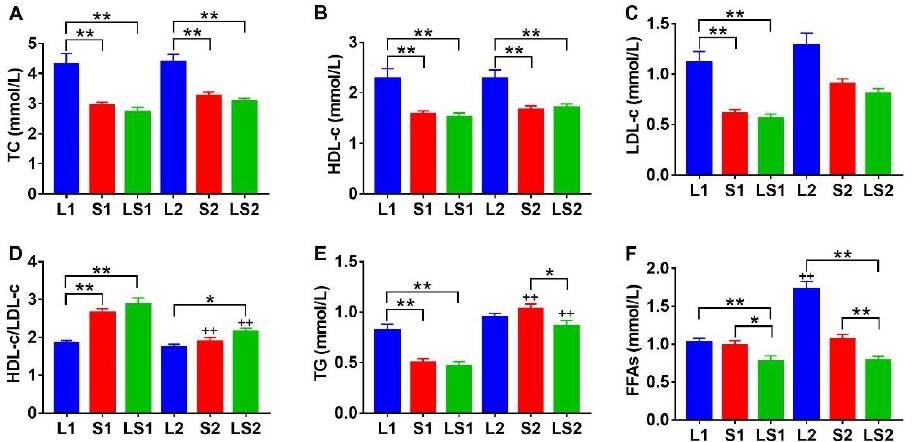
Figure 3. Impacts of various oil/fat diets on serum ( A ) total cholesterol (TC), ( B ) high density lipoprotein cholesterol (HDL-c), ( C ) low density lipoprotein cholesterol (LDL-c), ( D ) ratio of HDL- c/LDL-c, ( E ) triglyceride (TG), ( F ) free fatty acids (FFAs). LDL-c was analyzed using Kruskal–Wallis, significance was determined by two-tailed unpaired t test, p value was adjusted using Bonferroni. “*” denotes marked differences at p < 0.05; “**” denotes marked differences at p < 0.01; “++” represented significant differences at p < 0.01 relative to the same oil type with different energy